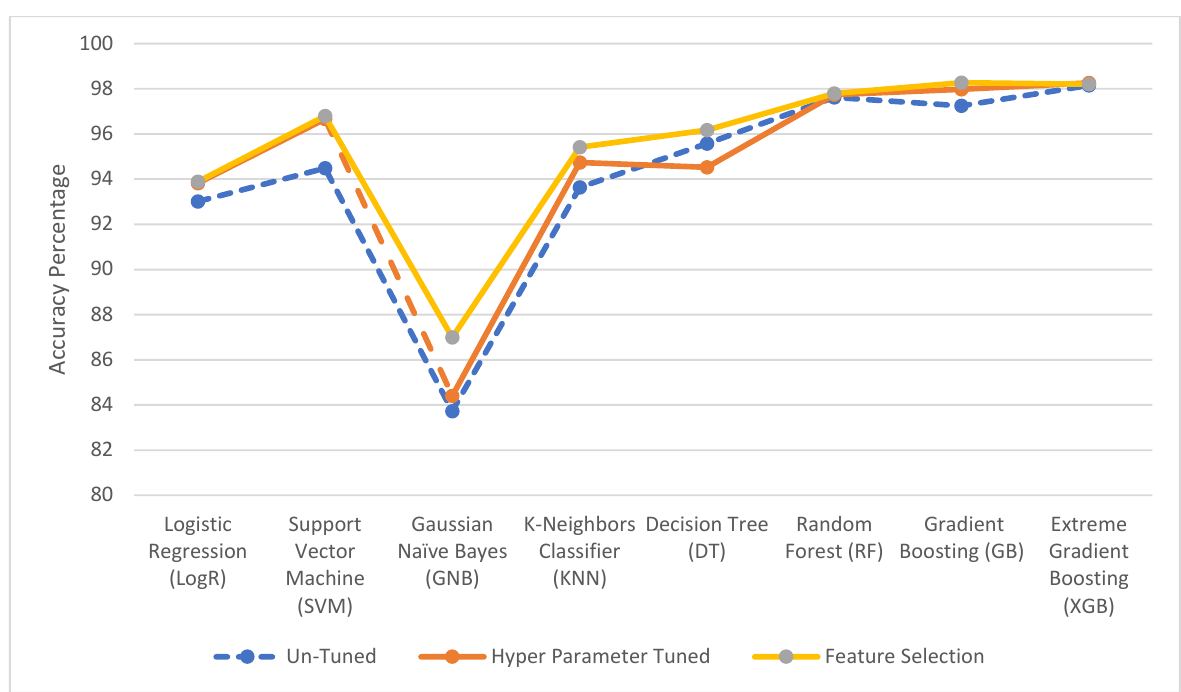
Figure 9. Dataset-2 performance (accuracy %) comparison.